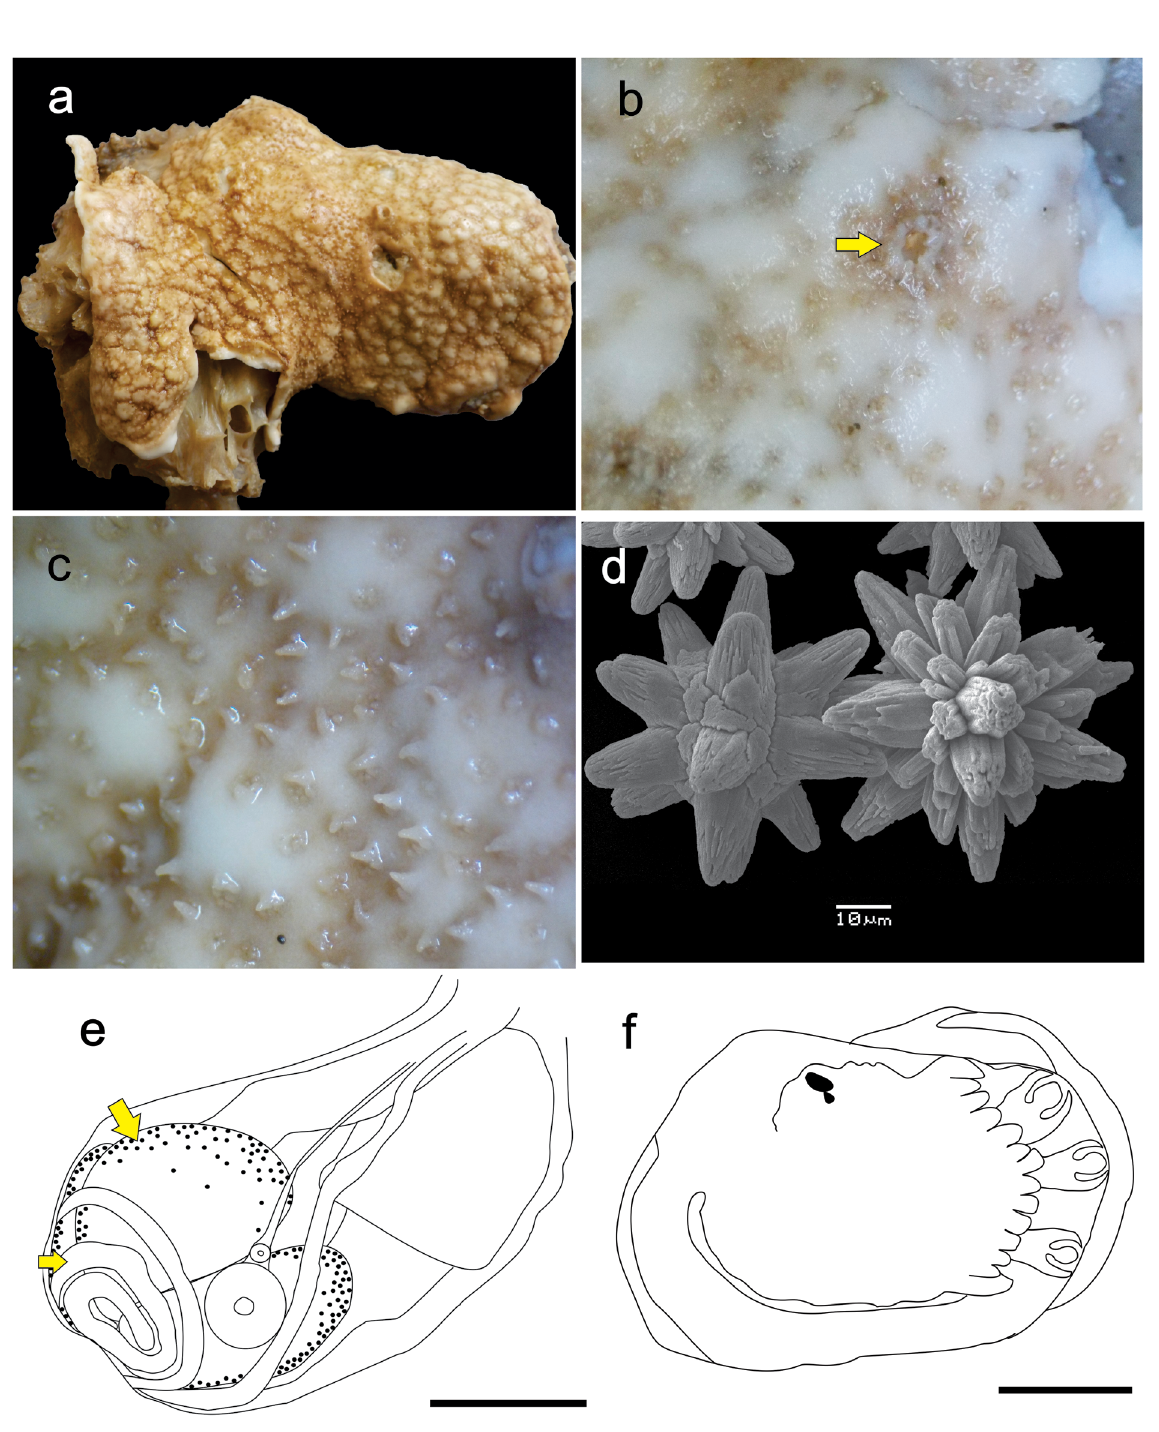
Fig. 11. Polysyncraton snelliusi Oliveira & Rocha sp. nov. a . Preserved colony. b . Colony surface (arrow indicates the common cloacal aperture with lobes). c . Papillae on the colony surface. d . Spicules (large type). e . Abdomen with gonads, large arrow indicates the follicle (one follicle hidden) and the small arrow the sperm duct. f . Larva. Scale bars: e–f = 0.2